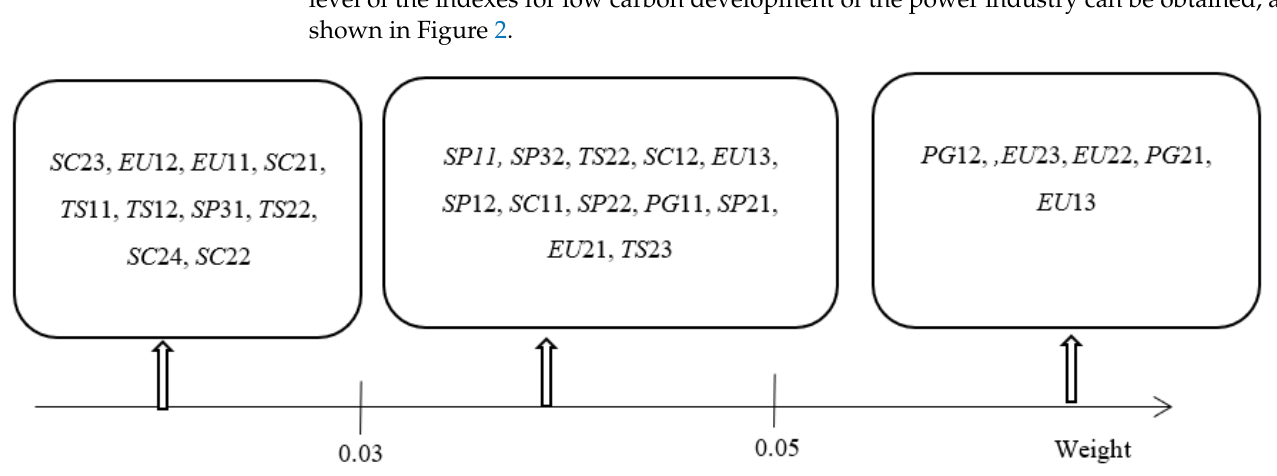
Figure 3. Evaluation score of low-carbon development in eastern China.